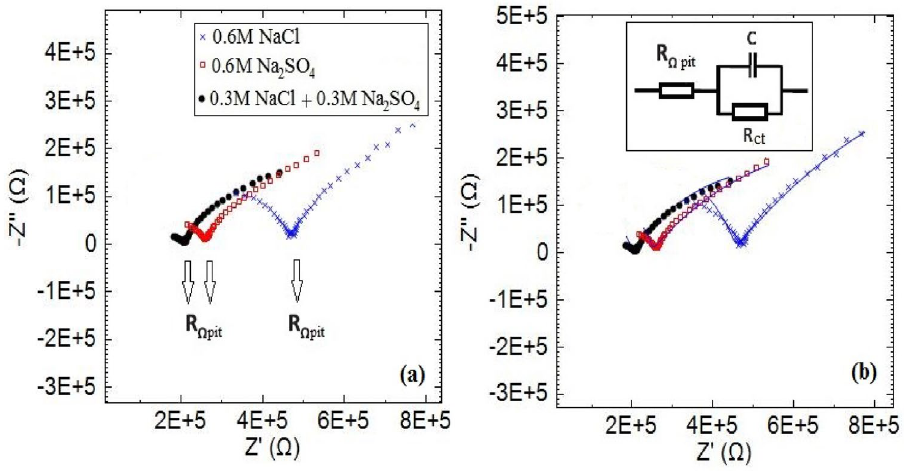
Figure 10. ( a ) The EIS plots of copper (3.14 mm 2 ) in different solutions at 60 °C. ( b ) The acceptable fit of the experimental data and Randles circuit.